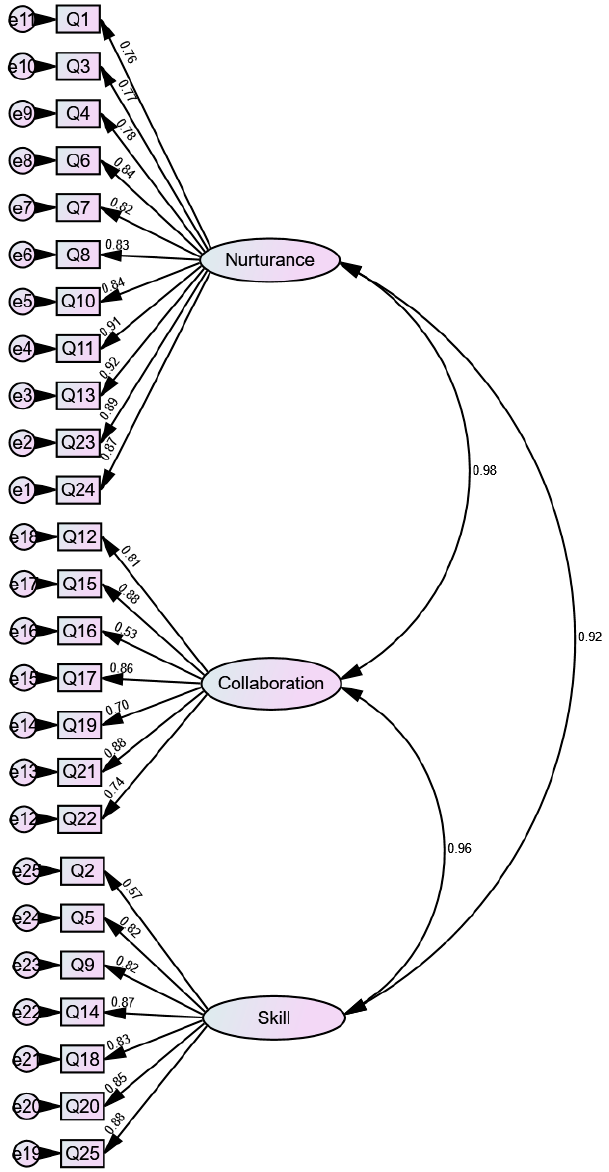
Figure 1. CFA for the CDI with standardized loadings.